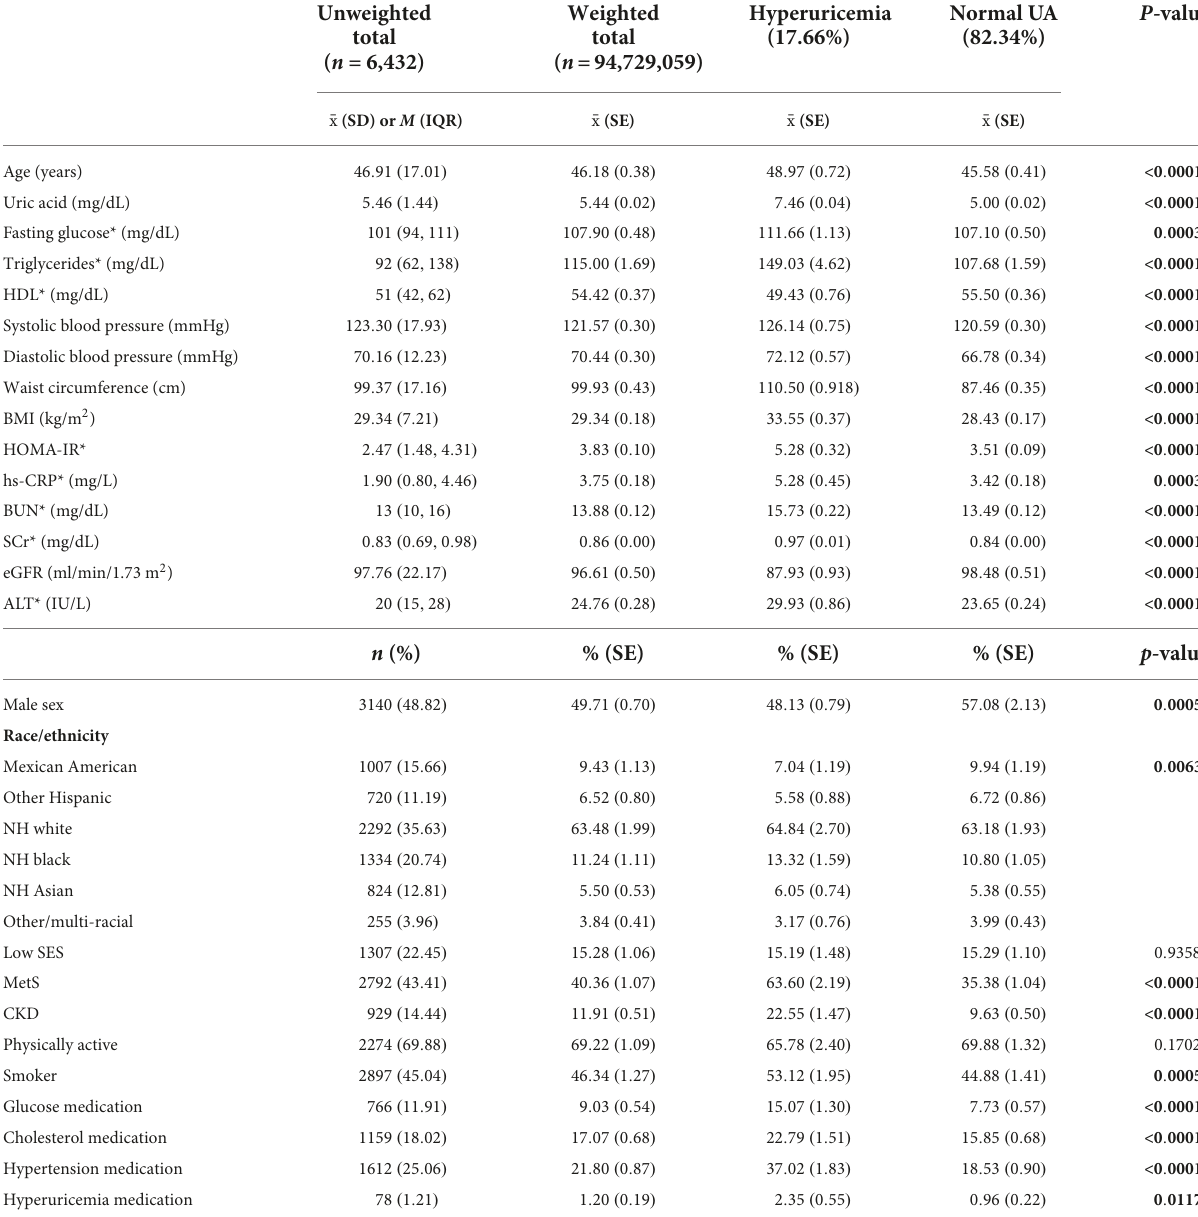
TABLE 1 Demographic information for the total sample, those with hyperuricemia, and those with normal uric acid (UA) levels. Unweighted